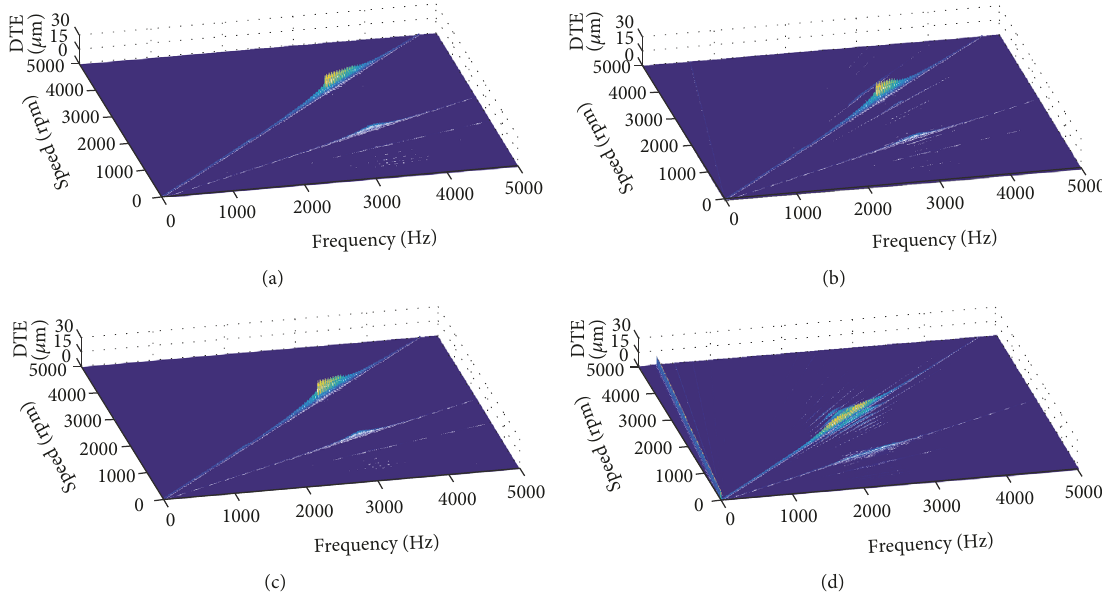
Figure 8: Waterfall diagram of the DTE for the four gear pairs